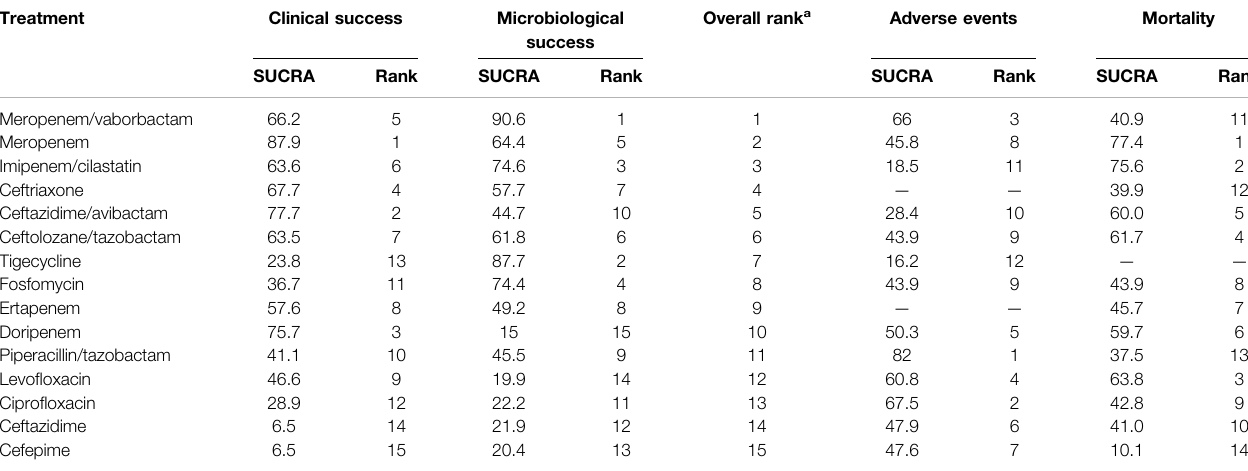
TABLE 1 | Results of SUCRA in primary and secondary outcomes for Enterobacteriaceae infections. Treatment Clinical success